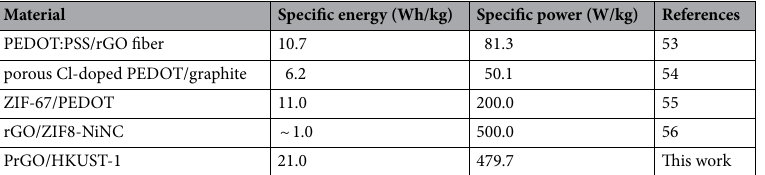
Table 2. Comparison of specific energy and specific power of proposed symmetric supercapacitor with other reported symmetrical supercapacitors. PEDOT:PSS/rGO fiber: poly(3,4-ethylenedioxythiophene):po ly(styrenesulfonic acid)/reduced graphene oxide, porous Cl-doped PEDOT/graphite: chloride ions doped poly (3, 4-ethylenedioxythiophene) porous nanostructures on graphite, ZIF-67/PEDOT: zeolitic imidazole frameworks-67/ poly(3,4-ethylenedioxythiophene), rGO/ZIF8-NiNC: reduced graphene oxide/zeolitic imidazole framework-8 nickel